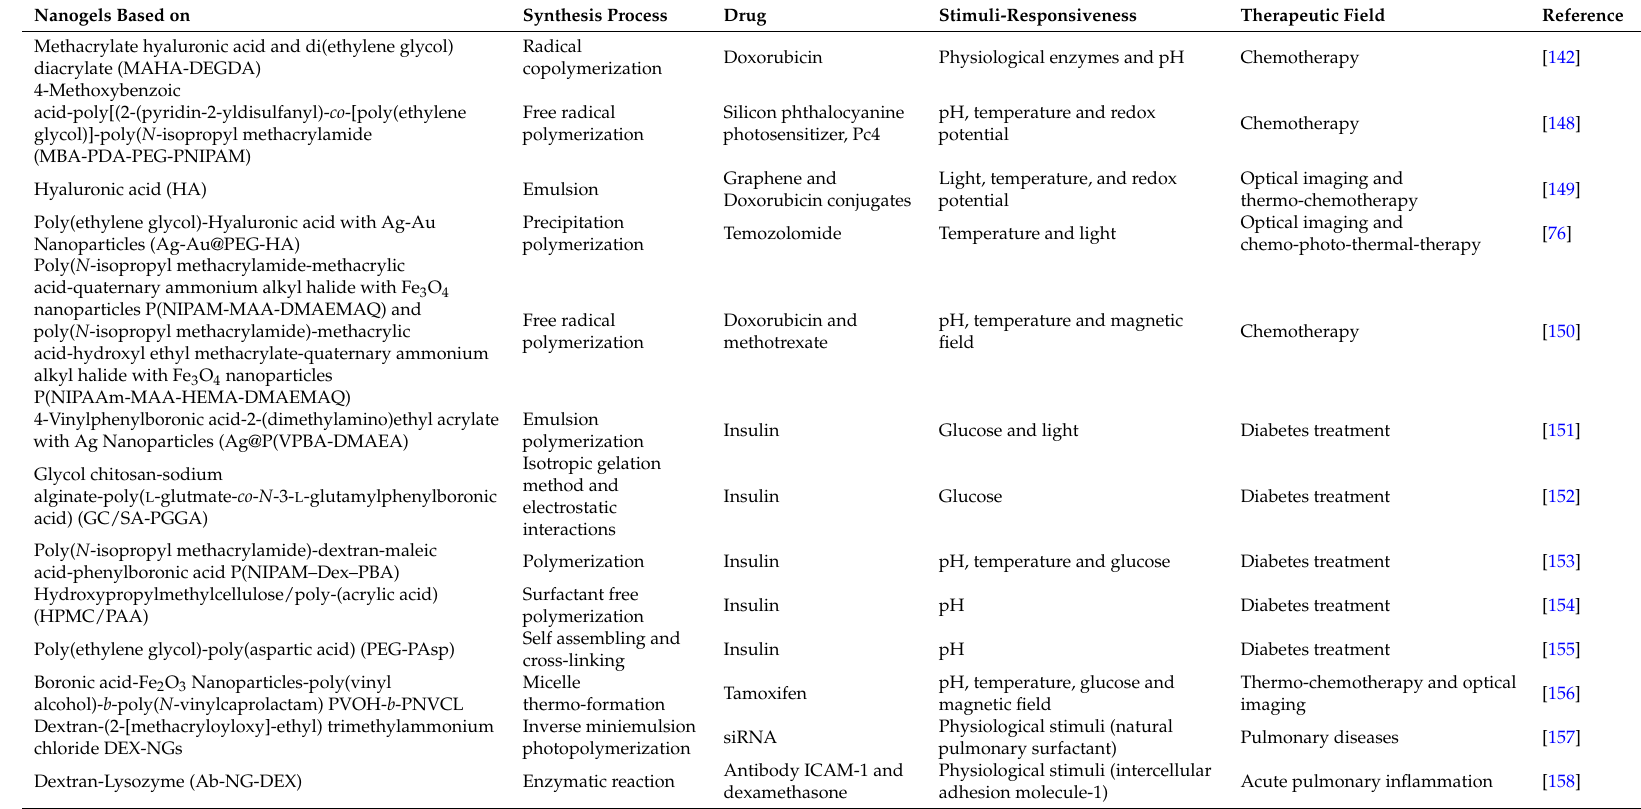
Table 1. Stimuli-responsive nanogels and their main uses in biomedical